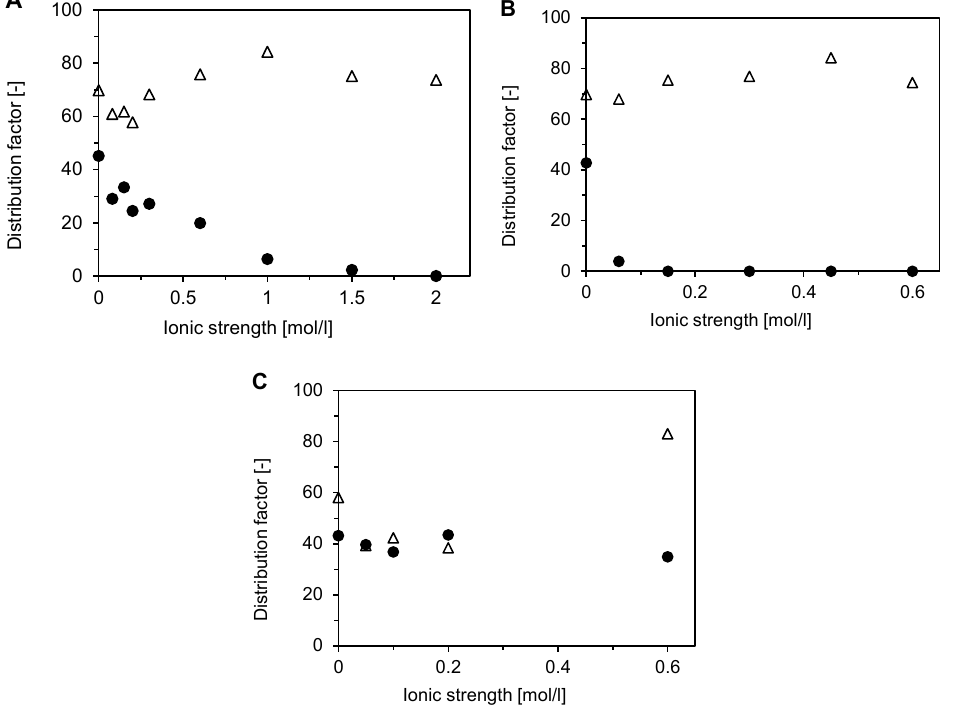
Figure 10. Influence of salt type and ionic strength on two-component adsorption of BSA ( ● ) and DNA ( △ ) on Sartobind STIC using a micromembrane module with pump-forced flow at pH 8. ( A ) NaCl, ( B ) Na 2 SO4, and ( C ) NH 4 Cl.